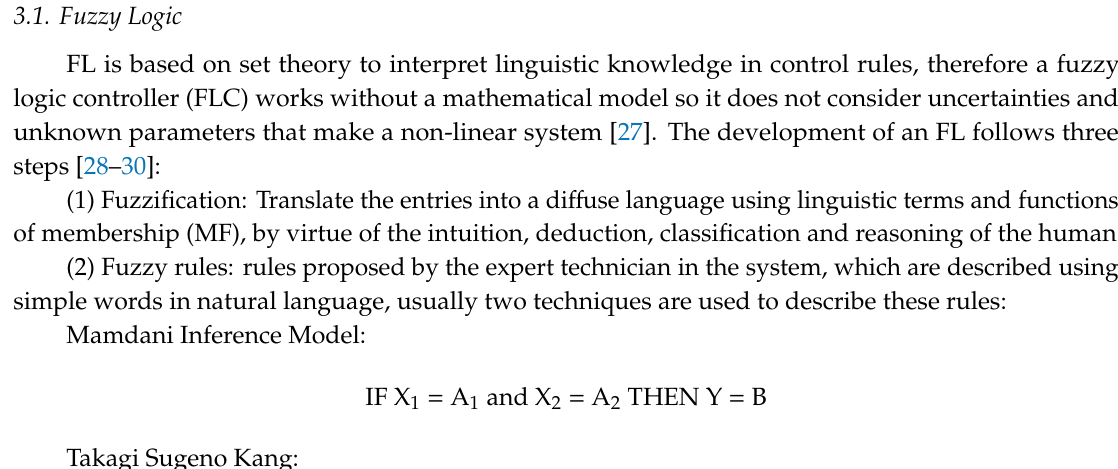
Figure 4. Artificial neuron model.